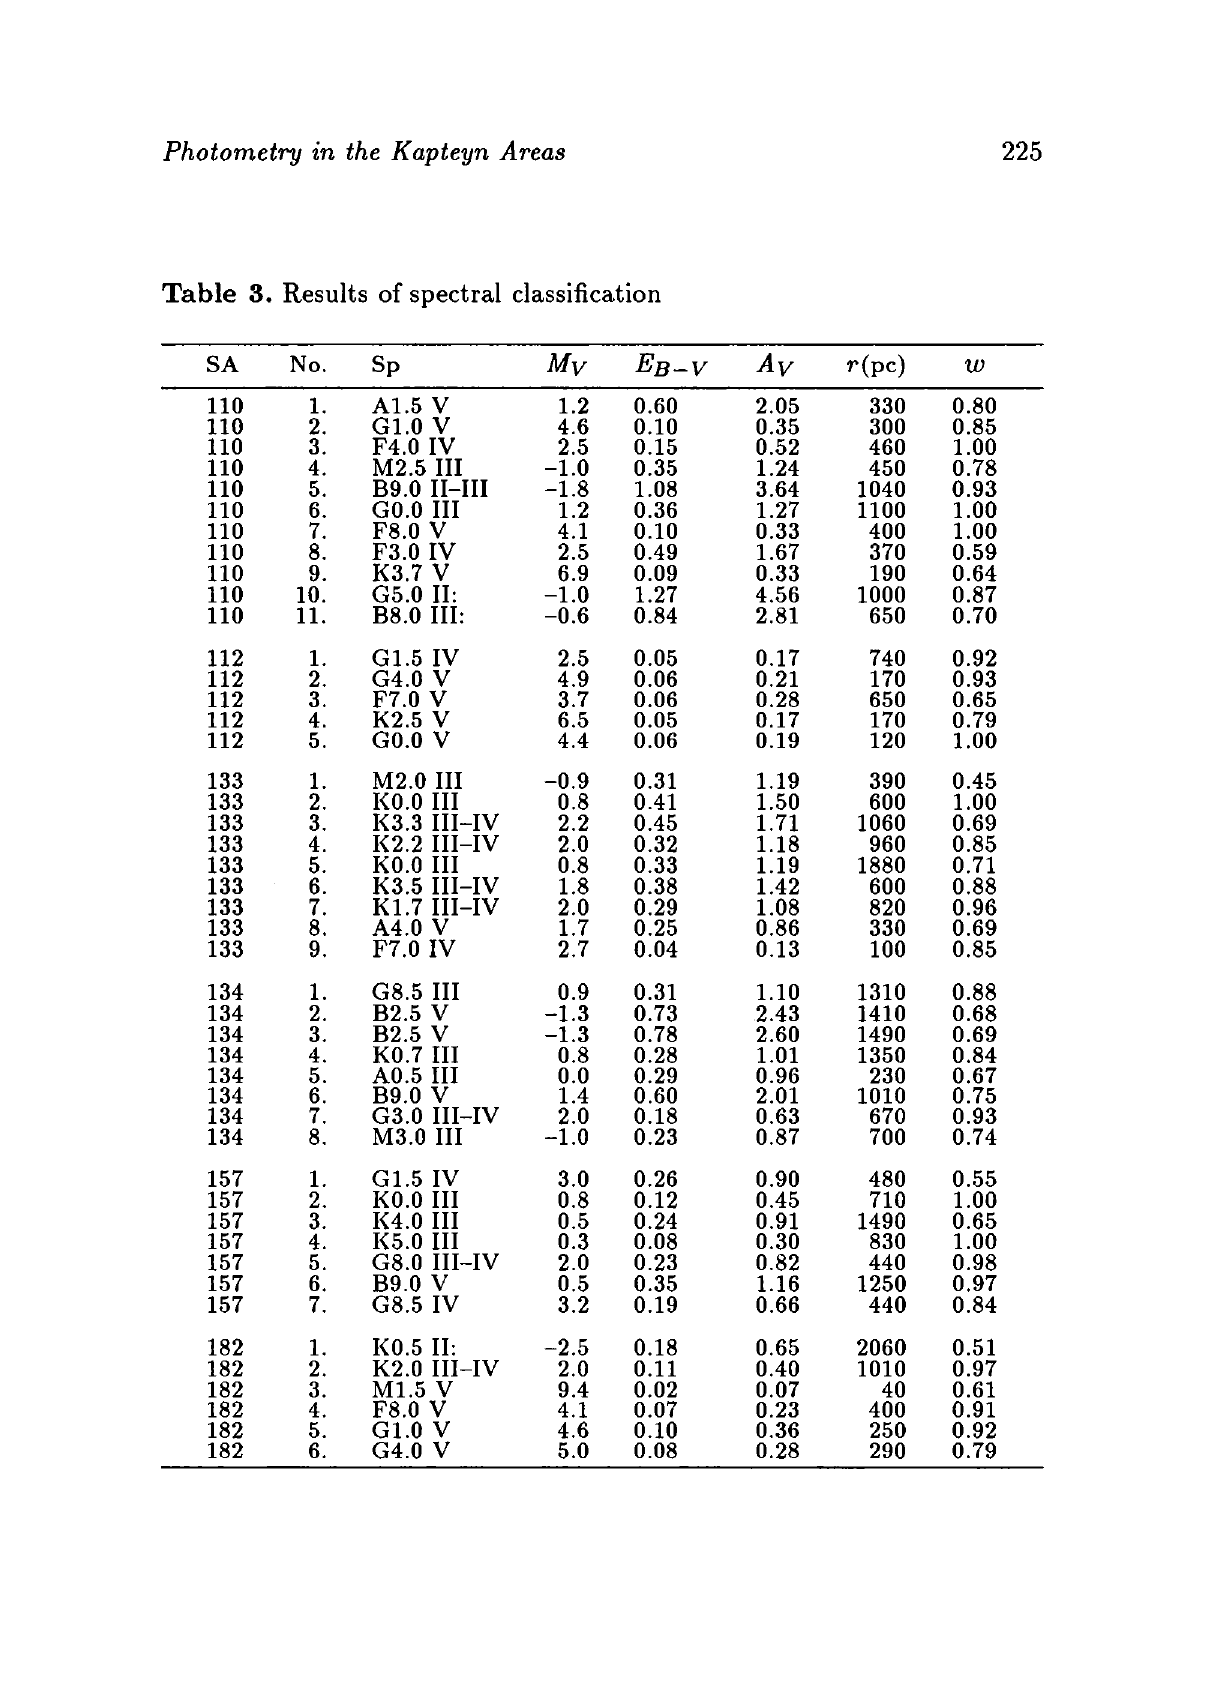
Table 3. Results of spectral